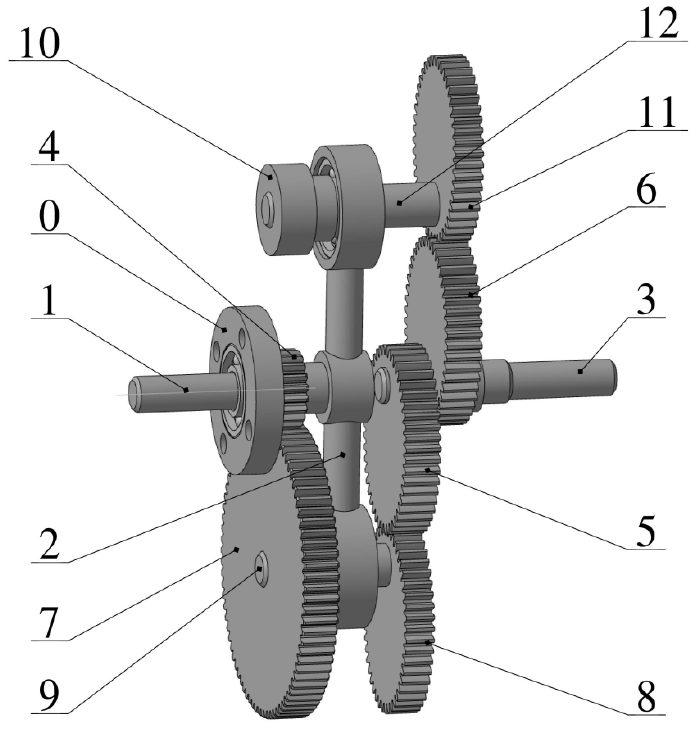
Figure 2. Intermittent motion planetary mechanism with elliptical gears.